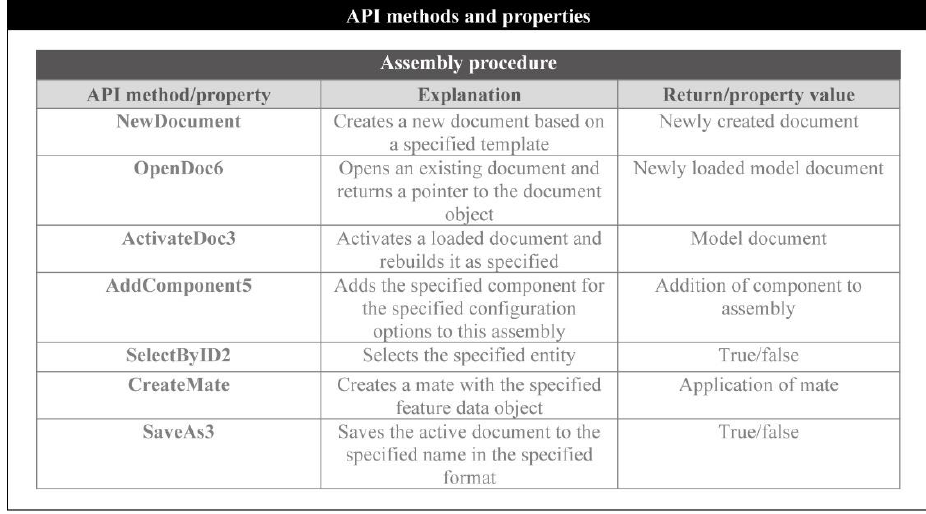
Figure 5. API methods and properties used for the assembly procedure.